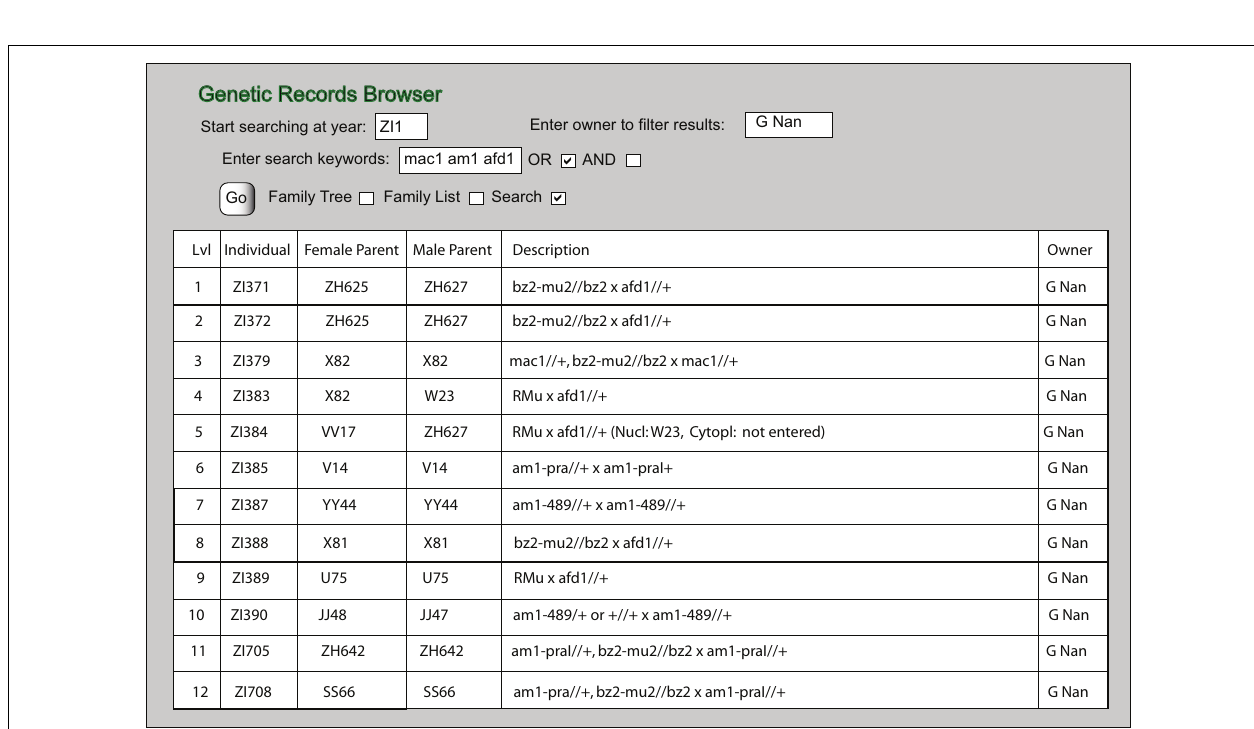
FIGURE 6 | Search display. Table showing search results of 15 records having either “mac1” or “am1” or “afd1” keywords.Table columns are